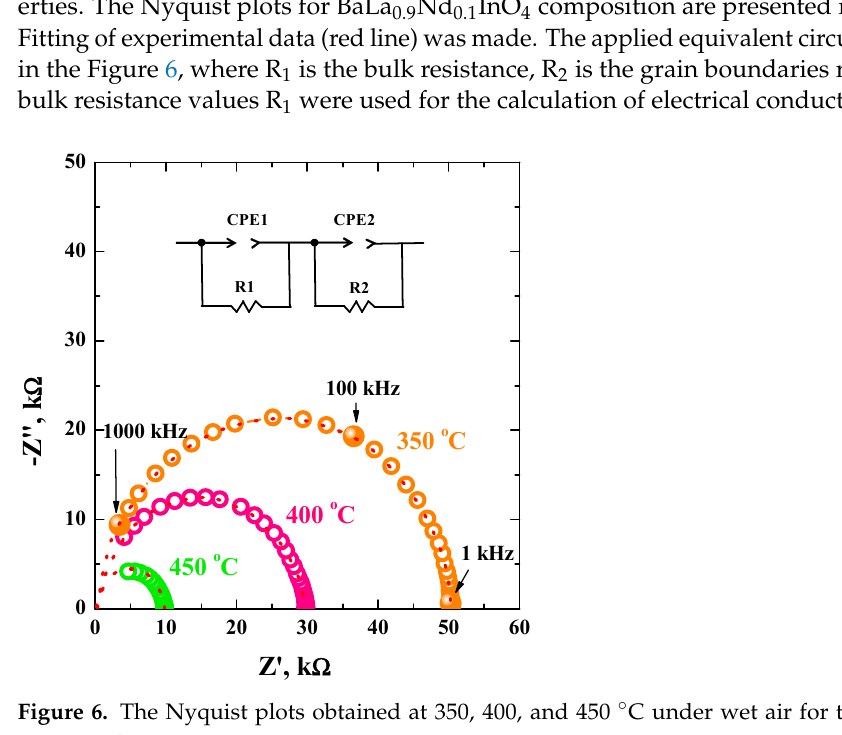
Figure 7. The conductivity dependencies form temperature for BaLa 0.9 Nd 0.1 InO 4 composition.